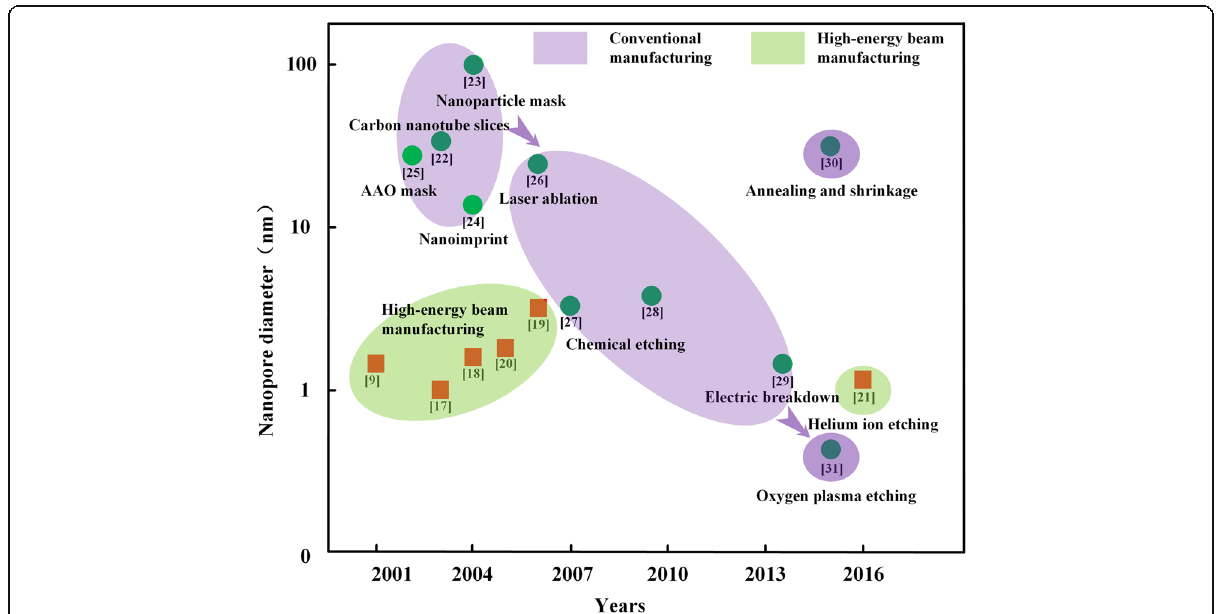
Fig. 1 Solid-state nanopore manufacturing technology development